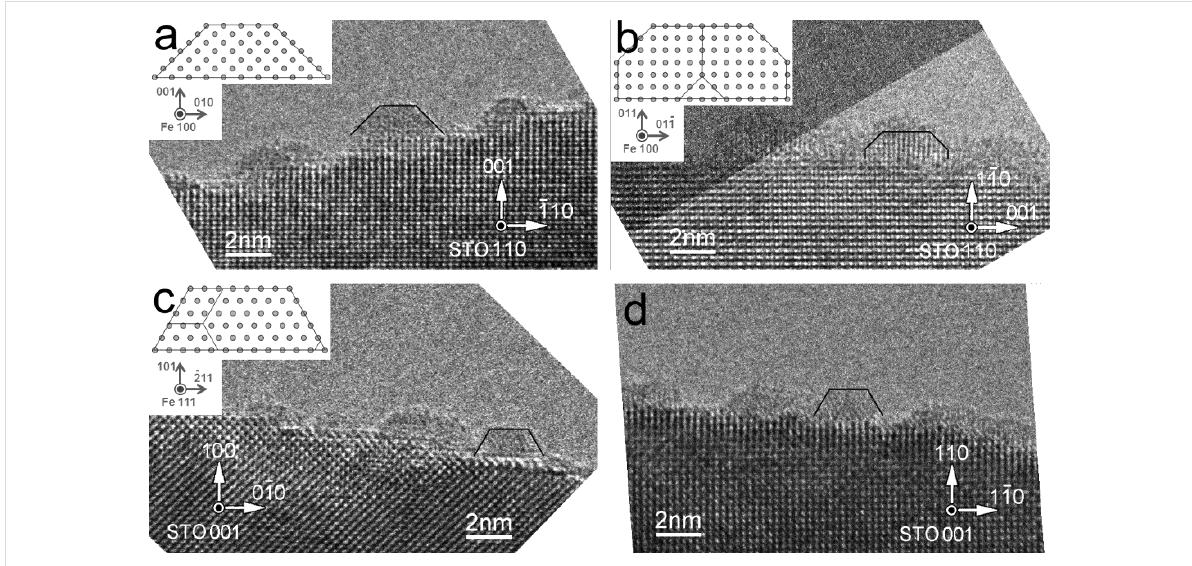
Figure 5: TEM profile-view images of Fe nanoparticles on substrate edges. a) Nanoparticles with OR1 orientation on STO (001); b) nanoparticles with OR2 orientation on STO ( ). Nanoparticles with minor orientations on c) STO(100) and d)STO (110).